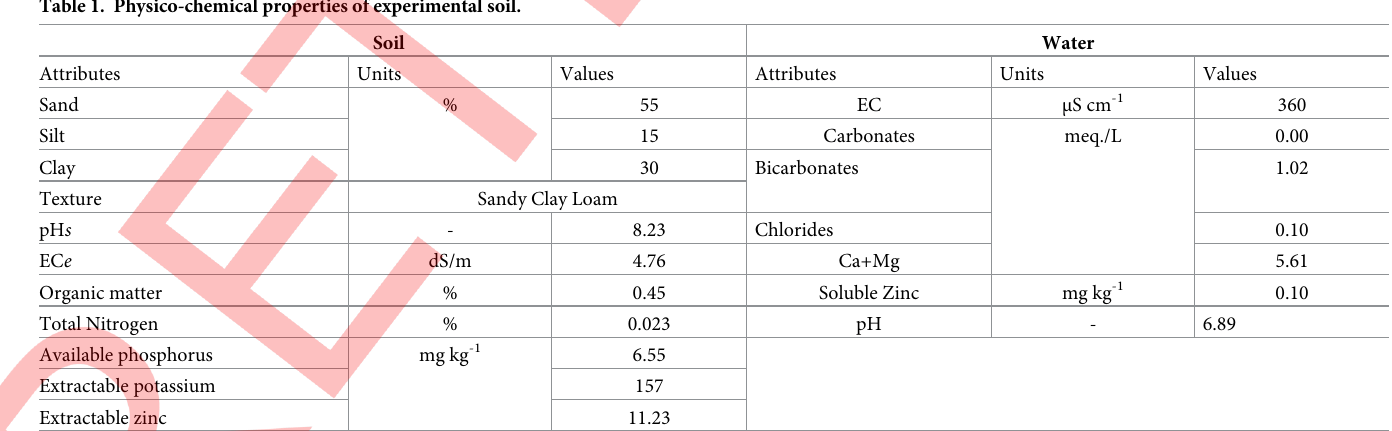
Table 1. Physico-chemical properties of experimental